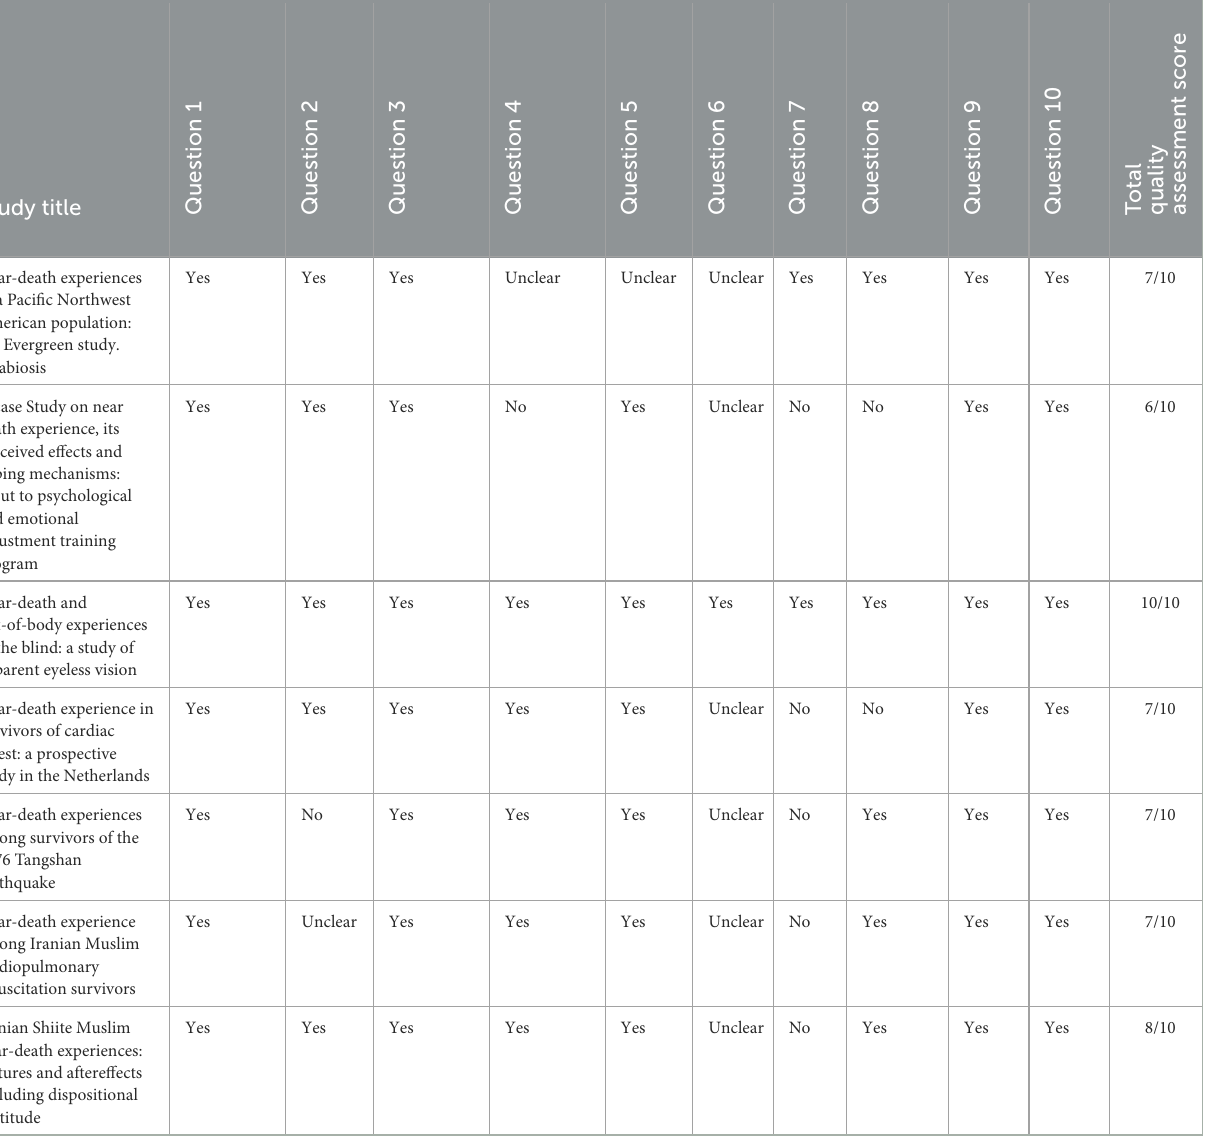
TABLE 6 Quality assessment for qualitative study that we include in this